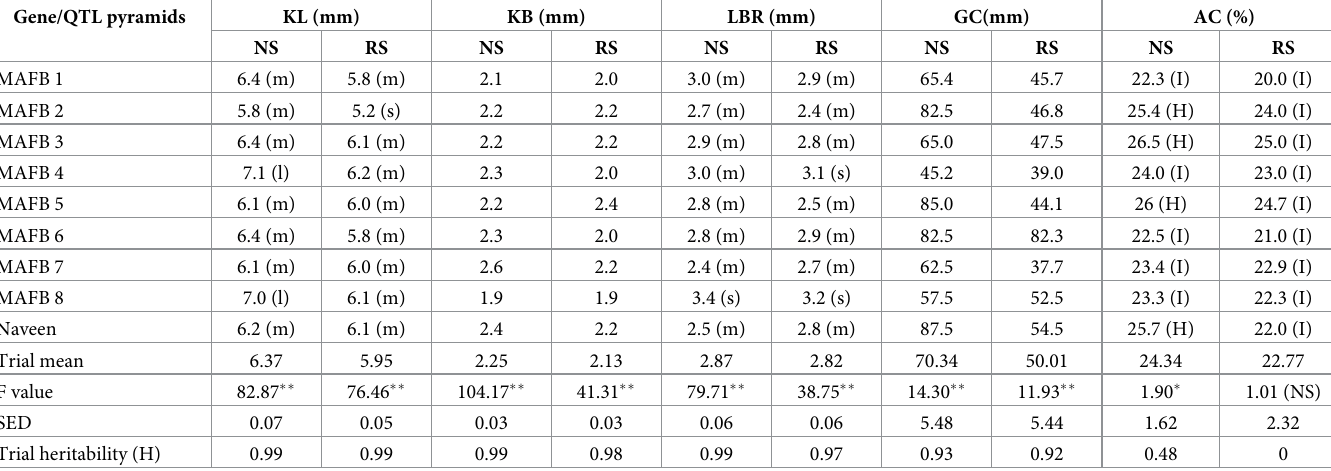
Table 5. Grain quality characteristics of MAFB lines under control and drought conditions during WS2018. Gene/QTL pyramids